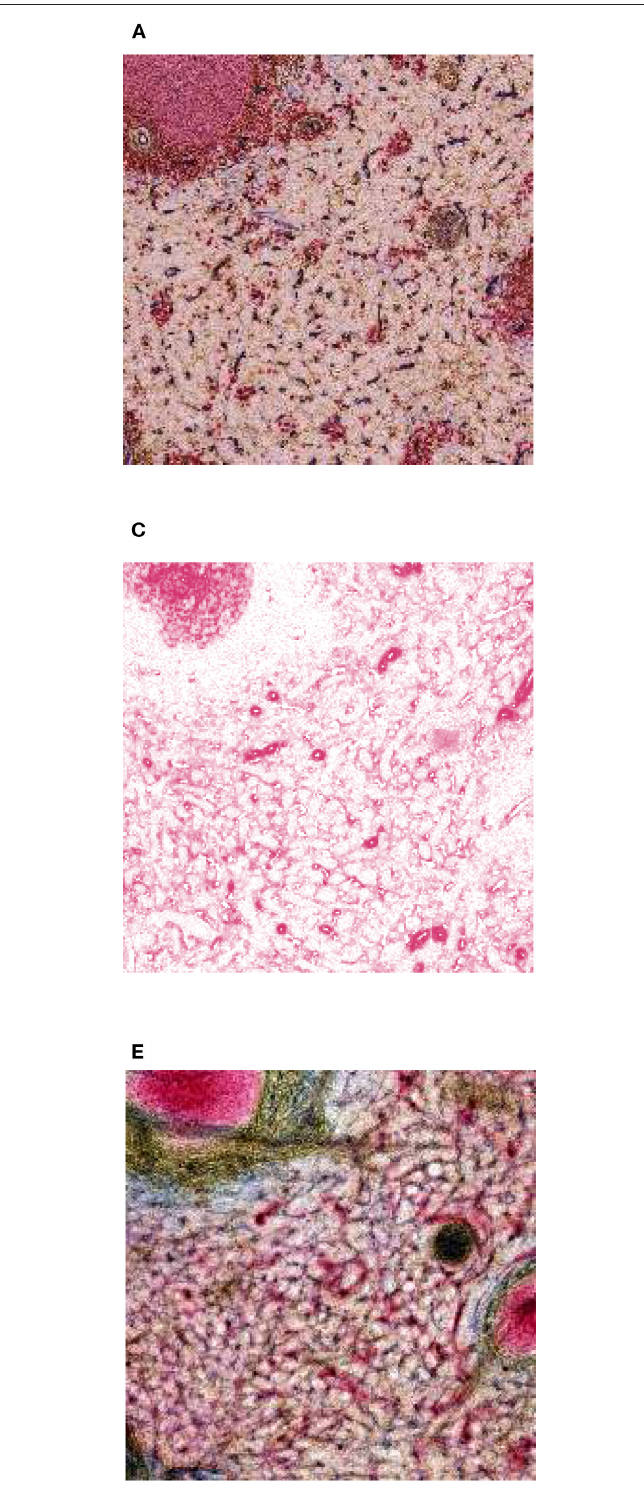
Frontiers in Virtual Reality |